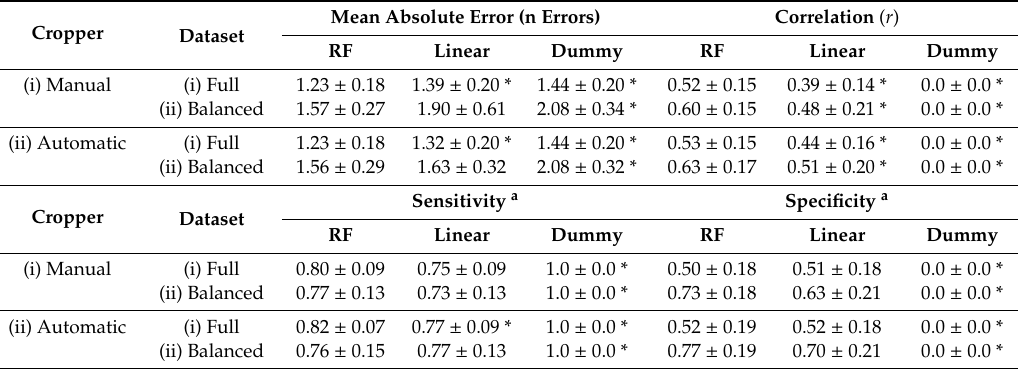
Table 4. Results from machine learning experiments.